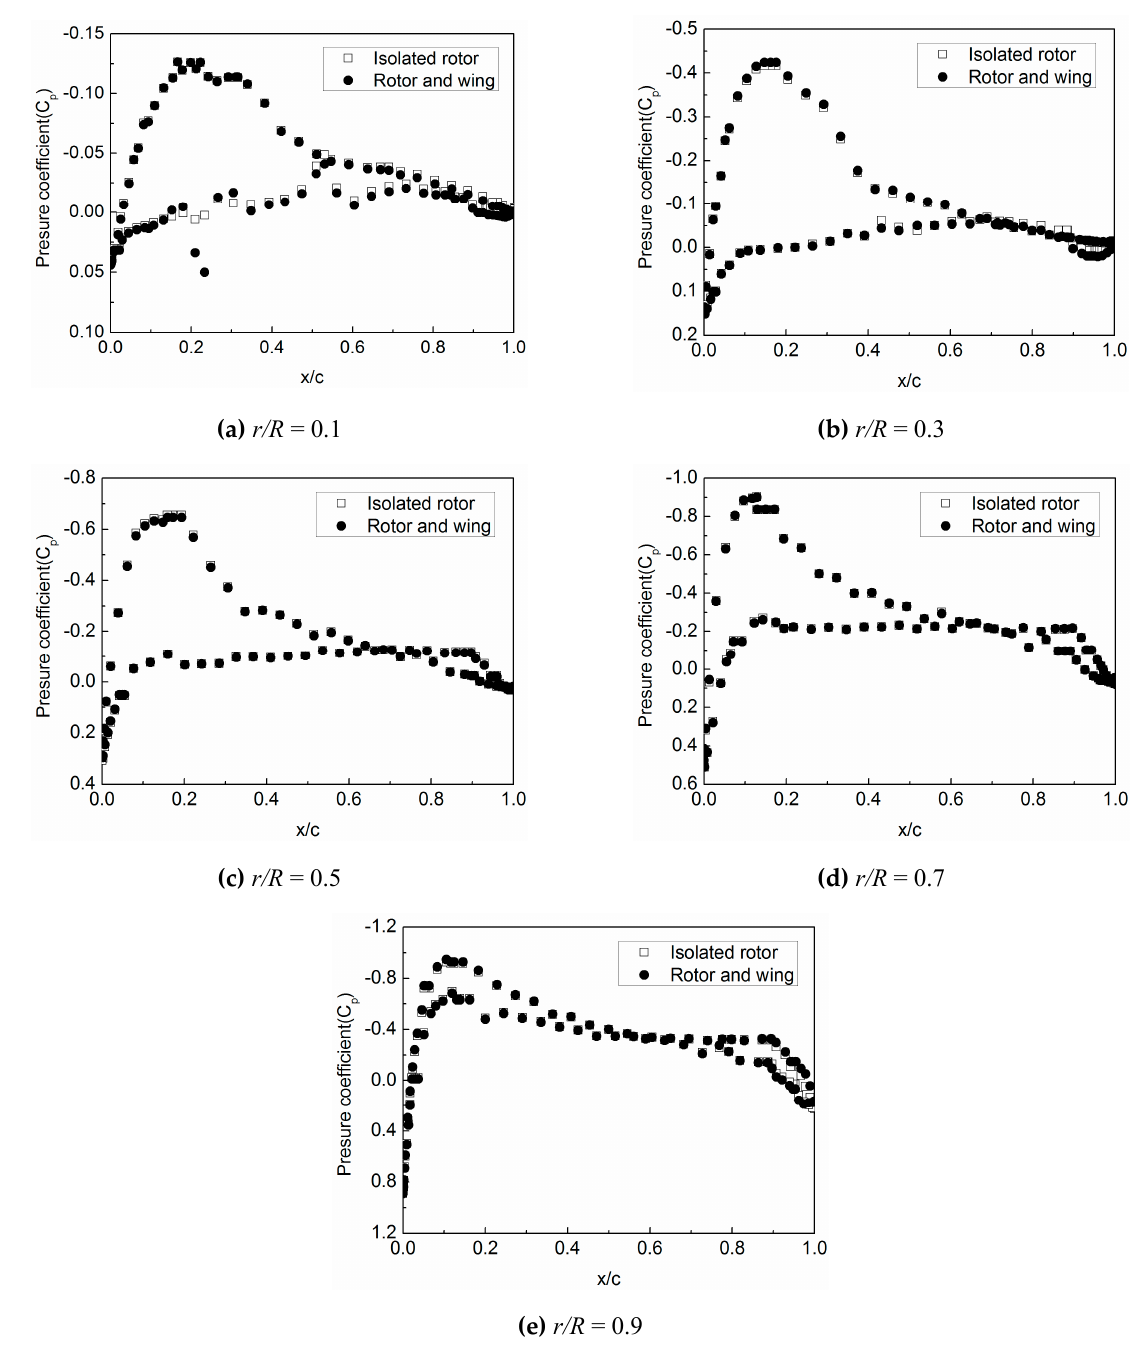
Figure 7. Pressure coefficient distributions on several blade sections for the isolated rotor and wing–rotor in hover. ( a ) r/R = 0.1; ( b ) r/R = 0.3; ( c ) r/R = 0.5; ( d ) r/R = 0.7;( e ) r/R = 0.9